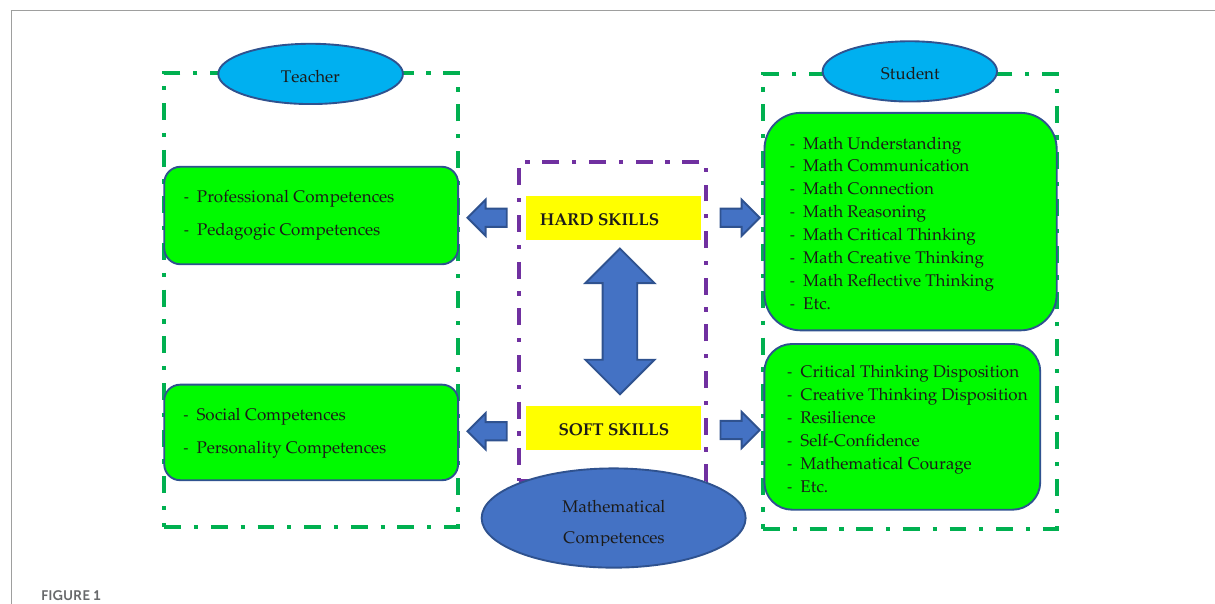
FIGURE1 Relationship of teacher and student